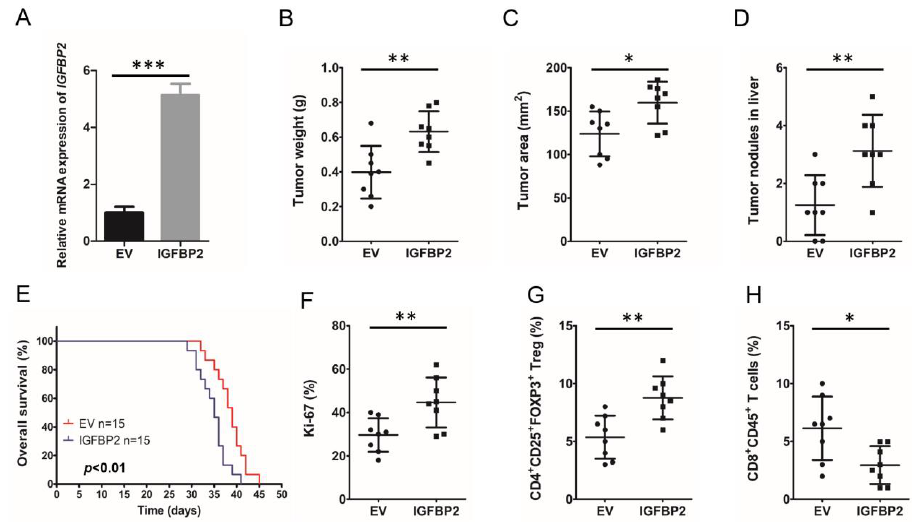
Figure 2. IGFBP2 increases Treg infiltration in the tumor microenvironment and promotes disease progression in mouse PDAC. ( A ) Panc02 cells stably overexpressing IGFBP2 were generated. IGFBP2 mRNA amounts were assessed by qRT-PCR, normalized to GAPDH (*** p < 0.001 by Stu- dent’s t -test). C57BL/6 mice were used for establishing an orthotropic PDAC model. The animals were divided into two groups and injected with IGFBP2-overexpressing (IGFBP2) or empty vector- transfected control (EV) Panc02 cells. Following 4 weeks, euthanasia was performed, and tumor extraction was carried out. Tumor weights ( B ), tumor areas ( C ), and tumor nodules in the liver ( D ) for both mouse groups are shown ( n = 8/group; * p < 0.05 ** p < 0.01 by the Student’s t -test). ( E ) The same orthotropic pancreatic carcinoma model was repeated, and the overall survival rates were analyzed ( n = 15/group; p < 0.01 by log-rank test). ( F ) Flow cytometry analysis of Ki-67 in tumor cells from both groups of C57BL/6 mice ( n = 8 per group; ** p < 0.01 by the Student’s t -test). CD4 + CD25 + FOXP3 + Tregs ( G ) and CD8 + CD45 + T cells ( H ) in the PDAC microenvironment in both mouse groups, assessed flow-cytometrically, are shown ( n = 8/group; * p < 0.05 ** p < 0.01 by the Student’s t -test). Data are mean ± SD from 3 or more assays performed independently. Four weekslater, euthanasia was carried out, followed by tumor extraction. The re- sults revealed Panc02-IGFBP2 tumors were markedly heavier ( p < 0.01) and larger ( p < 0.05) than those of the Panc02-EV group (Figure 2B,C). The Panc02-IGFBP2 group also showed a higher number of hepatic metastatic foci compared with the Panc02-EV group ( p < 0.01; Figure 2D). High IGFBP2 expression was also associated with markedly de- creased OS in an independent mouse population ( n = 15/group) ( p < 0.01; Figure 2E). We next performed flow cytometry for detecting Ki-67 positive cells in fresh tissue, and Panc02-IGFBP2 tumors had a higher proliferation rate than Panic02-EV tumors ( p < 0.01; Figure 2F).